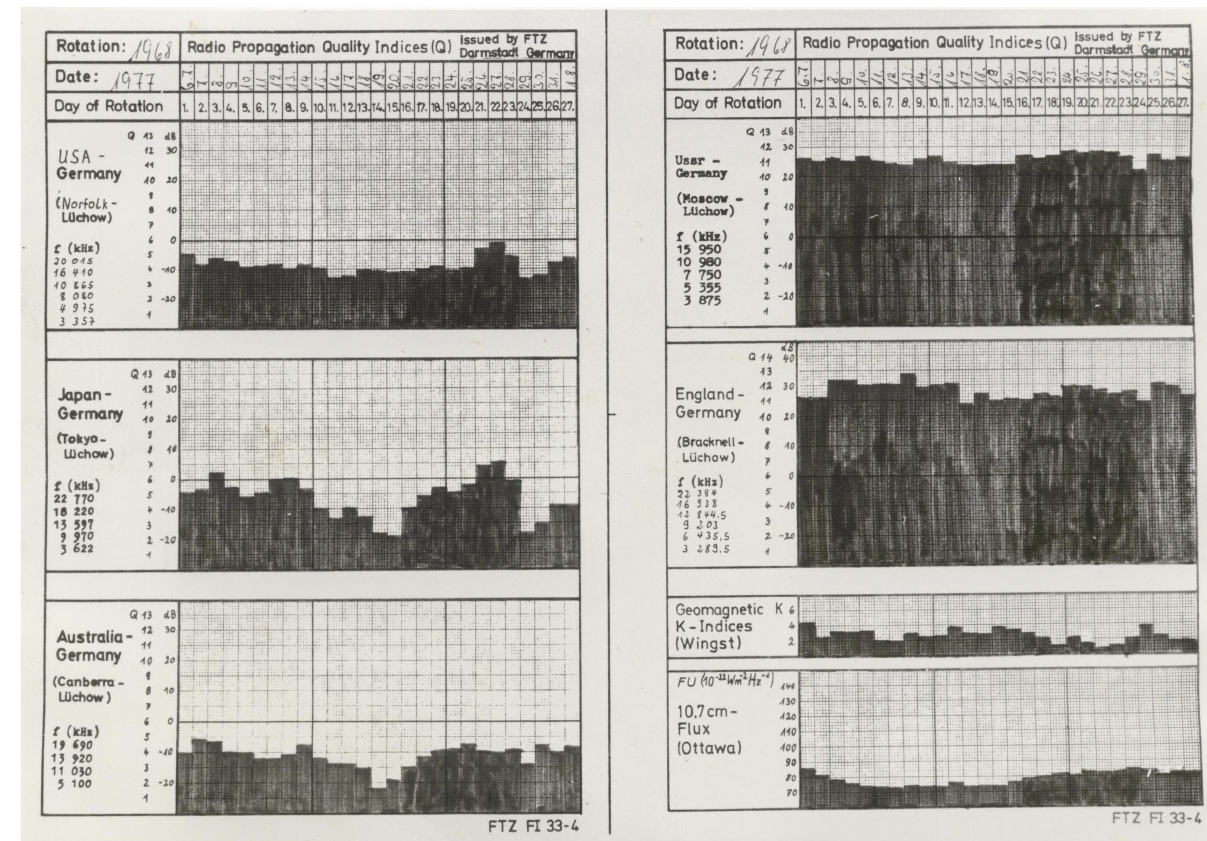
Figure 2. For each circuit, daily “Quality Indices” were calculated and arranged in solar